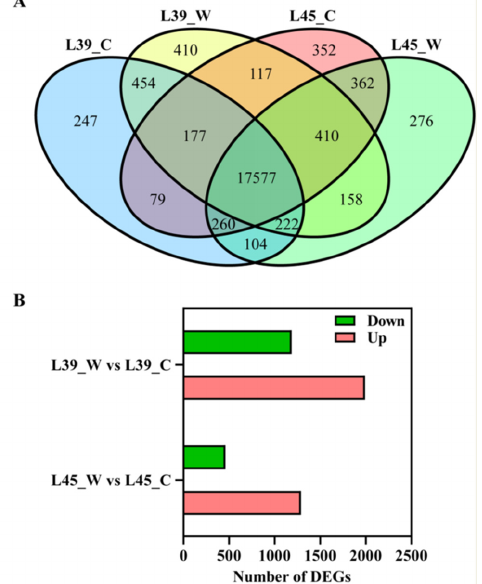
Figure 4. A survey of gene expression under control and waterlogging stress conditions. ( A ) Venn diagrams of all expressed genes in the different samples. ( B ) Statistical histogram of differentially expressed genes (DEGs).